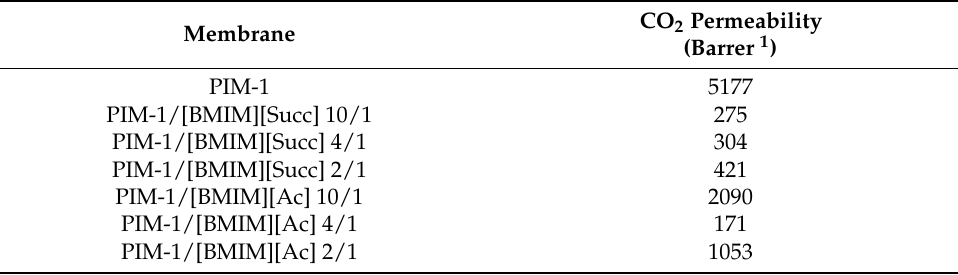
Table 2. CO 2 Permeability at 1 bar pressure derived from flow cell experiments.